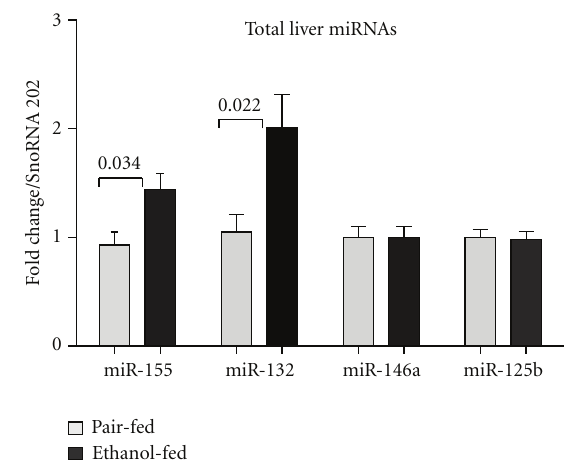
Figure 1: Increased expression of miR-155 and miR-132 in the livers of alcohol-fed mice. C57BL/6 eight-week-old female mice ( n = 6/group) were fed with Lieber-Decarli diet either containing 5% alcohol (ethanol-fed) or isocaloric liquid diet (pair-fed) for 4 weeks. After 4 weeks, the livers were isolated and stored in RNA later (Qiagen) for RNA analysis at − 80 ◦ C. Total RNA from livers was isolated using the miRNeasy kit (Qiagen), and quantification of miRNAs was carried out by TaqMan miRNA assays (Applied Biosystems). The data were normalized to SnoRNA202 (endoge- nous control) and shown as fold change over the pair-fed control group. Data represent mean values ± S.E.M. Statistical significance was determined using T-test